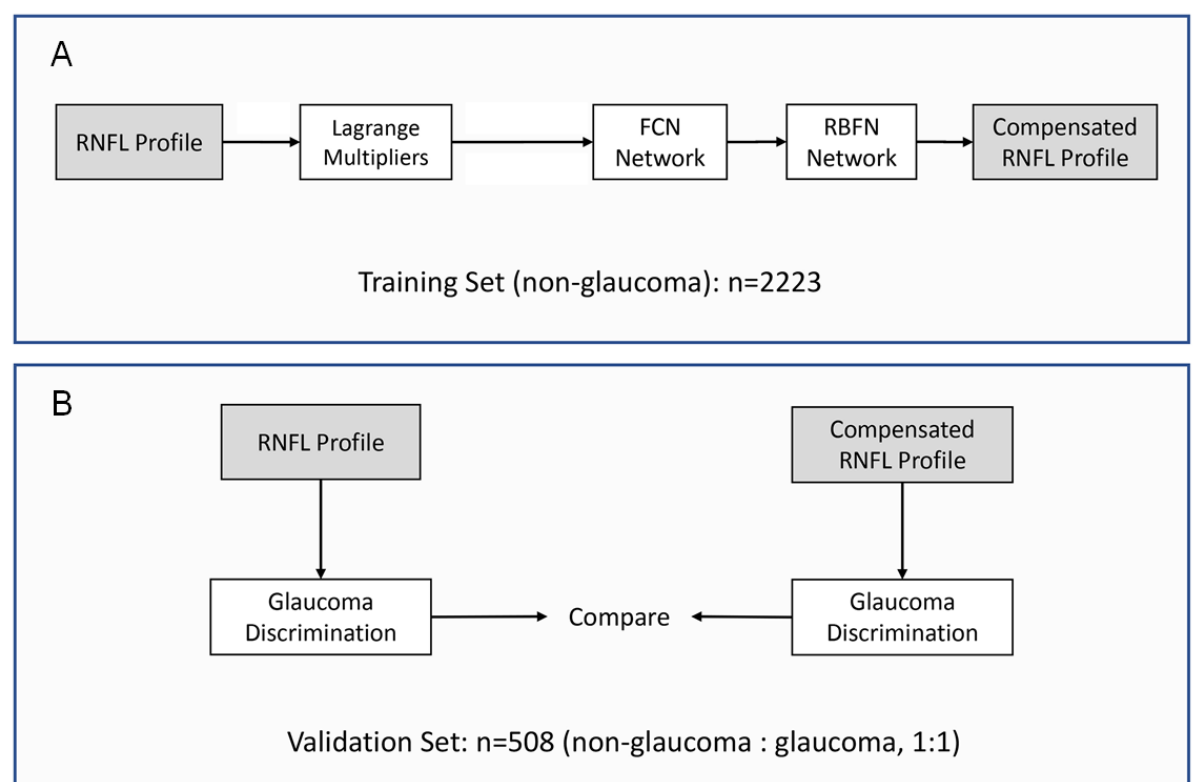
Figure 1. Overview of the 2-phased process in retinal nerve fiber layer (RNFL) profile compensation and its validation in discriminating glaucoma, which consisted of (A) applying the Lagrange multiplier, fully connected network (FCN), and radial basis function network (RBFN) to the training set, composed of 2223 eyes from 2223 nonglaucomatous participants, for RNFL thickness (RNFLT) compensation based on the impact of axial length (AL), age, disc-fovea angle (DFA), and disc fovea distance (DFD) and (B) evaluation of the performance of compensated RNFLT for glaucoma discrimination by comparing with the performance of the original RNFL